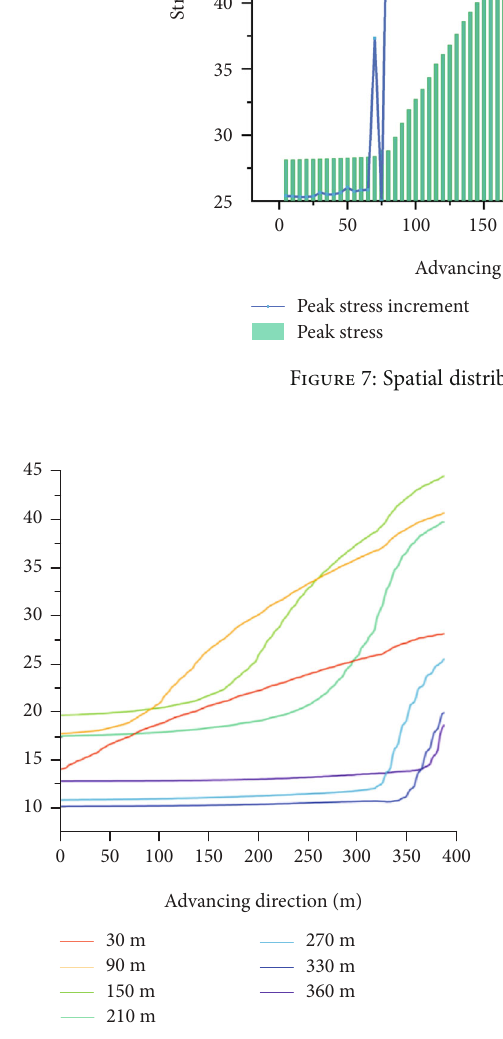
Figure 8: Relationship between di ff erent positions and stress variation in coal